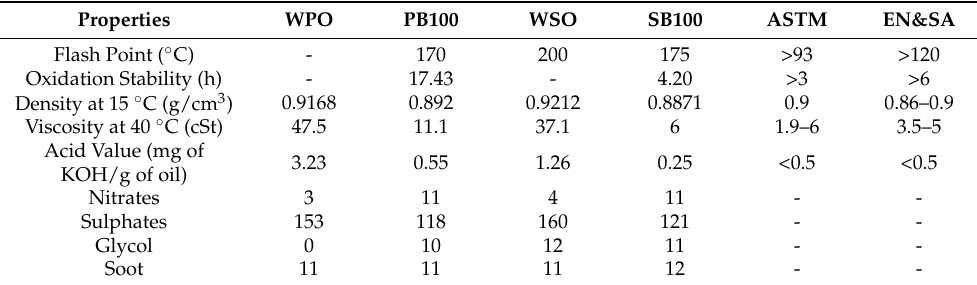
Table 4. Physico-chemical properties of waste oils and respective biodiesels